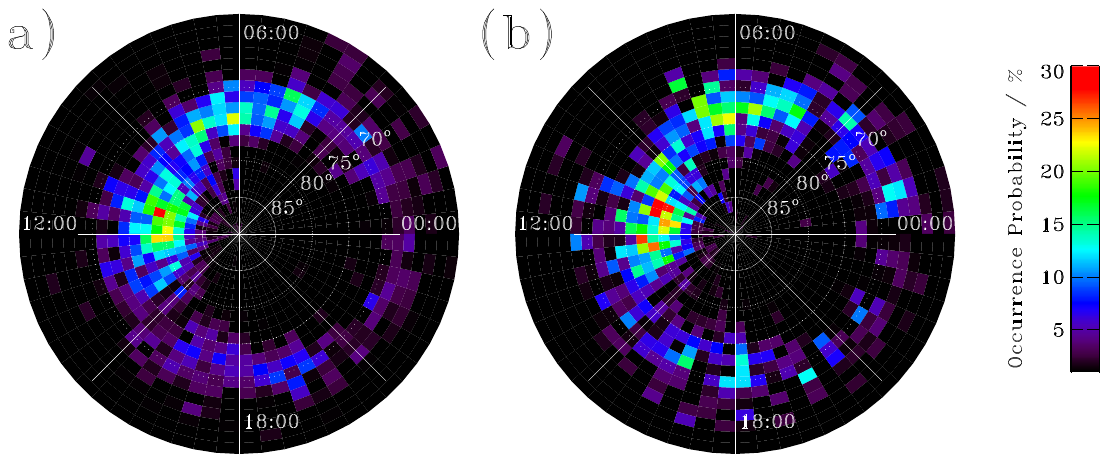
Fig. 5. He 2 + ion occurrence probabilities sampled during (a) IMF B X /B Y < 0 and (b) IMF B X /B Y > 0 conditions. The data are shown in the same format as Fig.